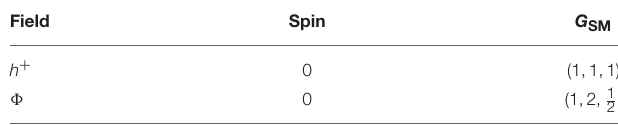
TABLE 6 | Quantum numbers for new particles in the Zee